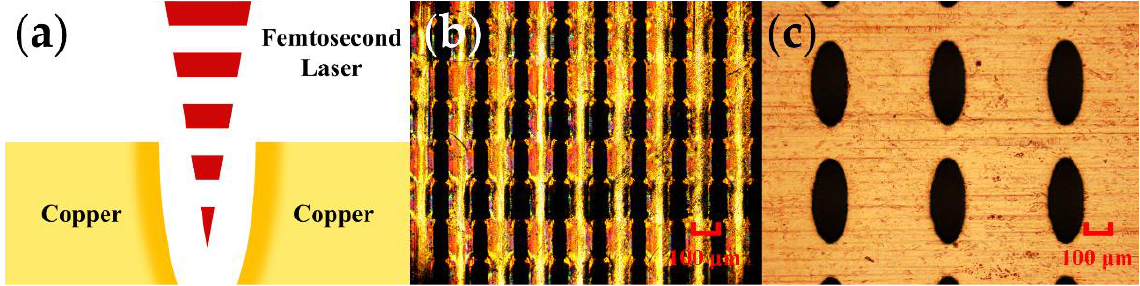
Figure 5. ( a ) Femtosecond laser processing schematic; ( b ) MSA metamaterial microscopy images; ( c ) Same size low-frequency MSA metamaterial microscopic images.